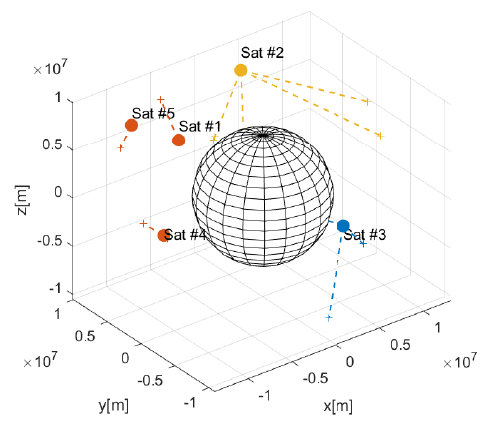
Figure 2. Task-planning visualization for results presented in Table 4. Filled circles, satellites; ‘+’, objects. Yellow, blue, and red represent Clusters 1–3, respectively.